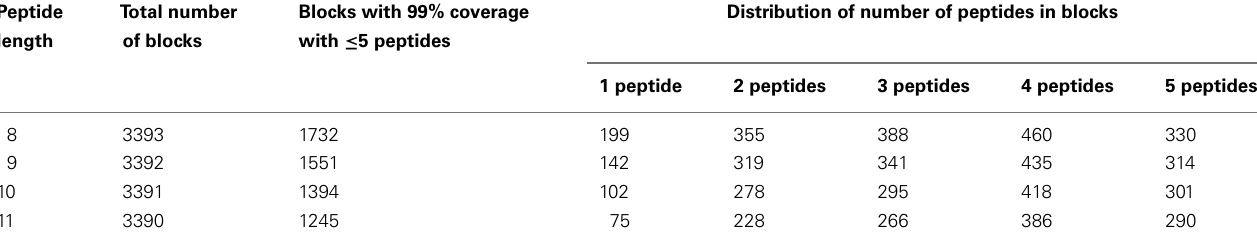
Table 2 |The total number of blocks which covers 99% of the sequences with five peptides or less, as well as the relative distribution of numbers of peptides in each block.